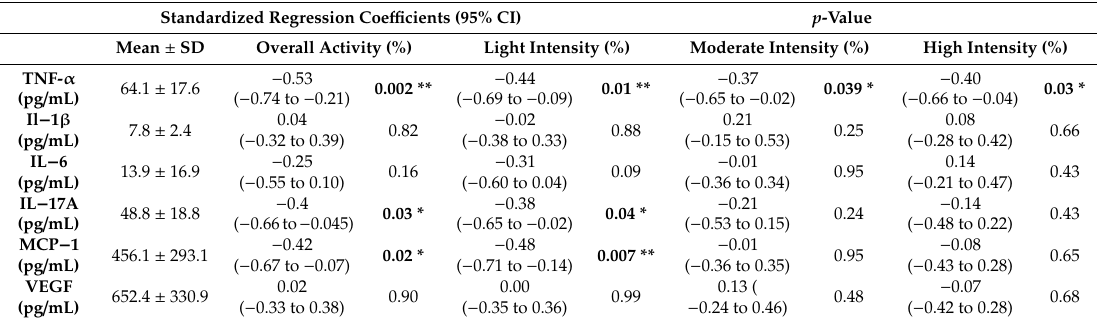
Table 4. Regression analysis of the percentage of time spent at di ff erent intensity levels of PA, metabolic risk variables, and inflammatory cytokines / chemokines in the circulation. Standardized Regression Coe ffi cients (95% CI) p -Value Mean ± SD Overall Activity (%) Light Intensity (%) Moderate Intensity